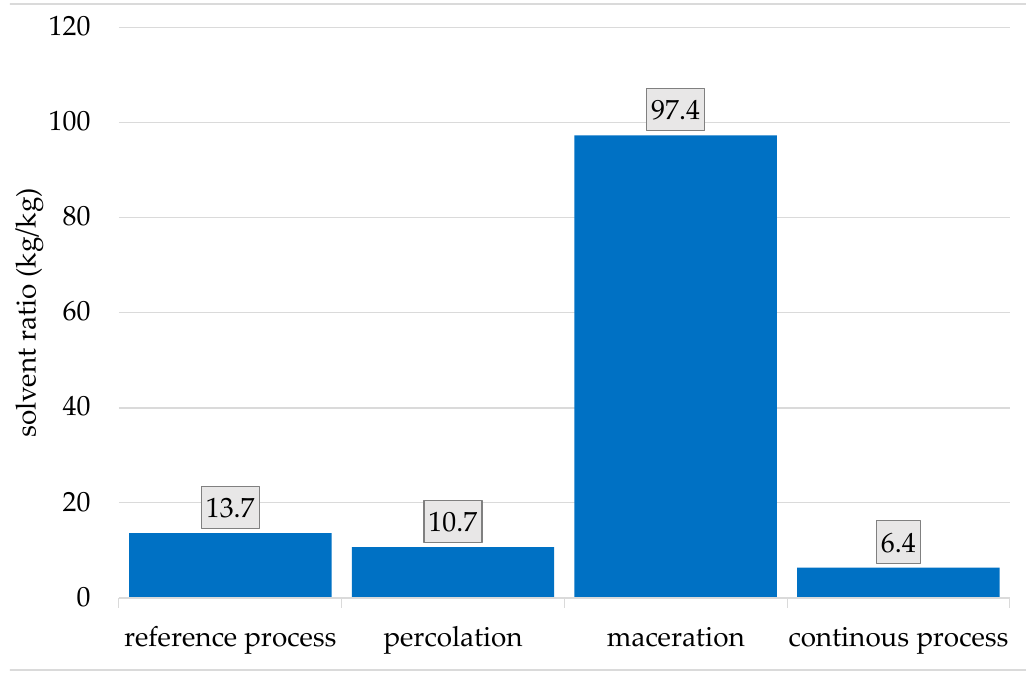
Figure 12. Comparison of different optimization approaches on total global warming potential (GWP) of the process. Pressurized hot water extraction (PHWE). Table 4. Optimization pathways for solid–liquid extraction. Pressurized hot water extraction (PHWE). Optimization Pathway